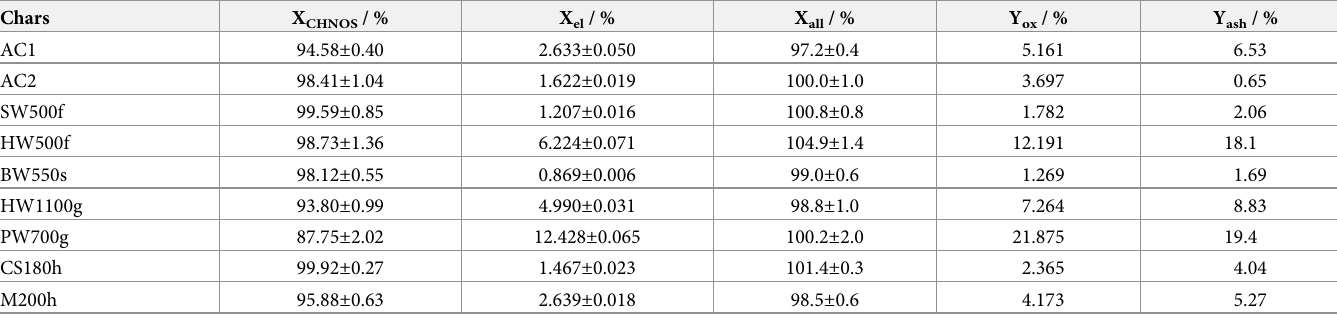
Table 4. Sum parameters of the chemical